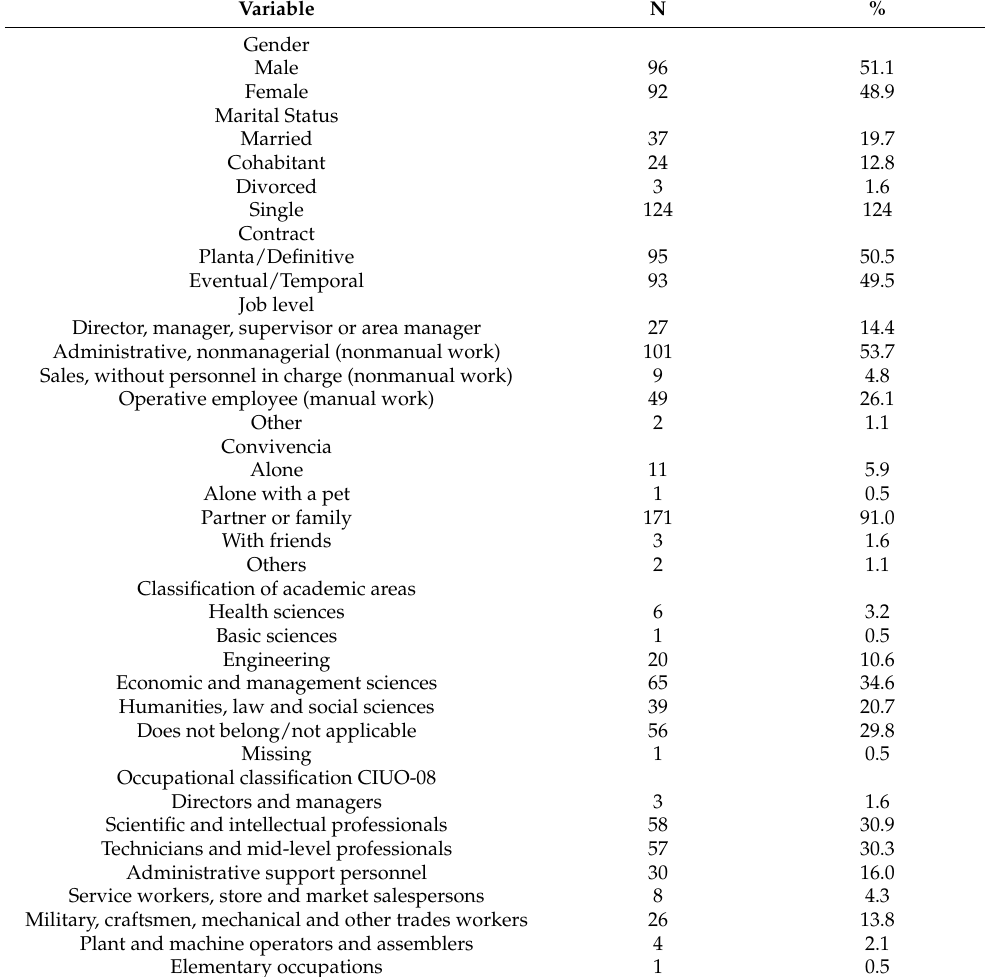
Table 1. Descriptive statistics of the effective study